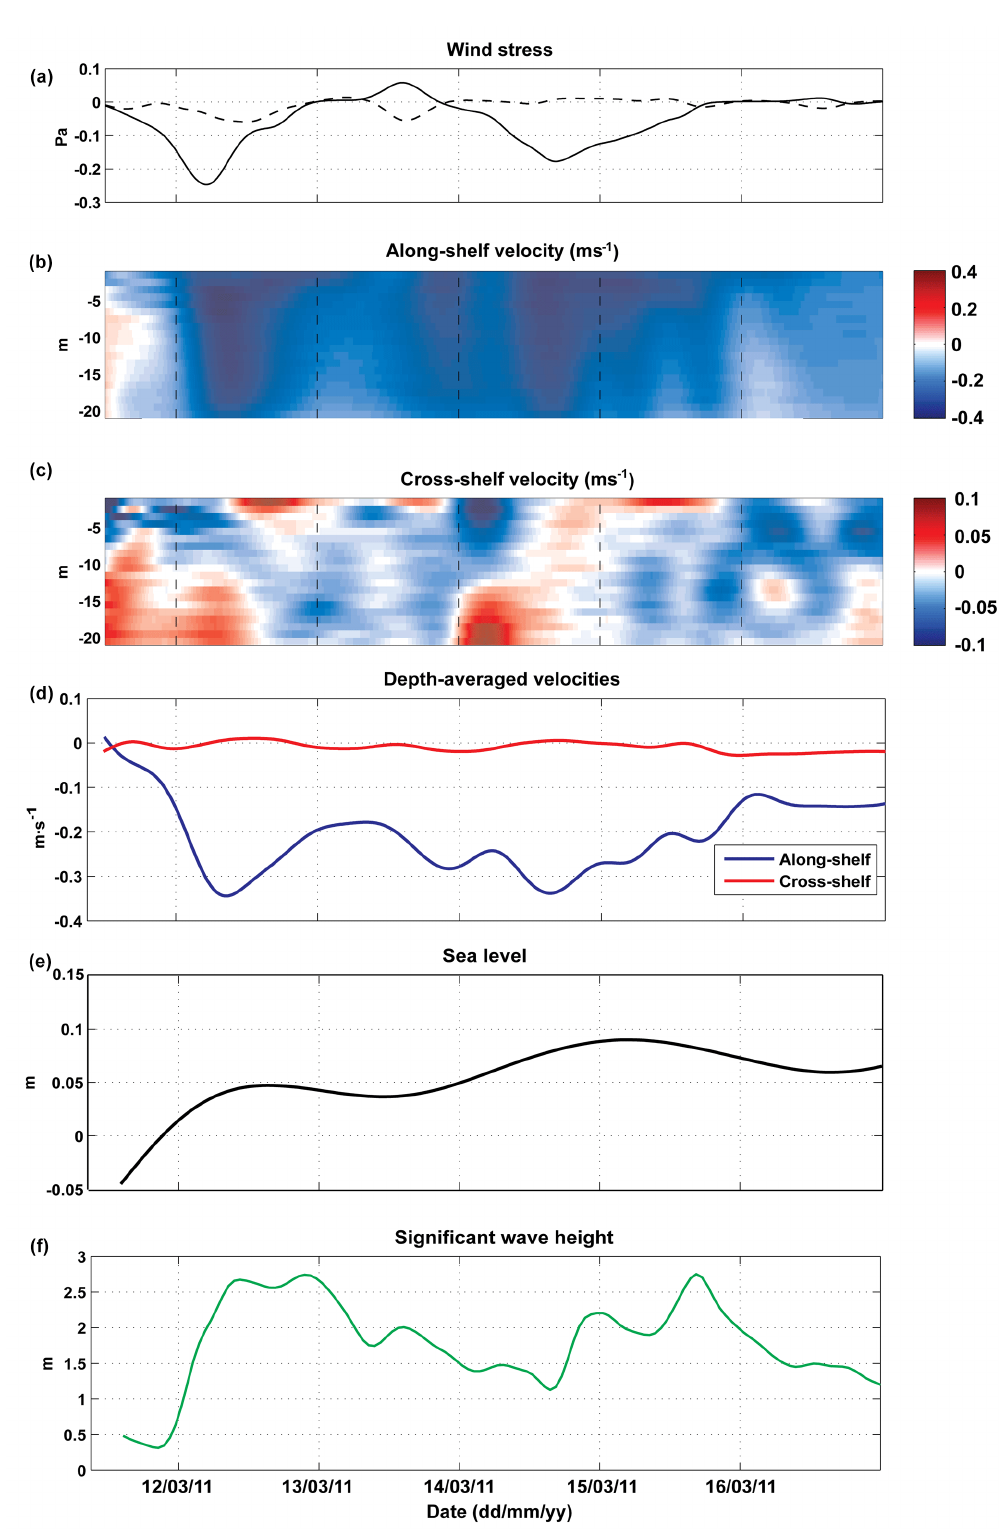
Figure 3. (a) Time series of wind stress measured at the CSO (the continuous line for the along-shelf wind component and the dashed line for the cross-shelf wind component). (b) Along-shelf velocity. (c) Cross-shelf velocity. (d) Depth-averaged along- and cross-shelf velocities. (e) Detided sea-level variations. (f) Significant wave-height. The velocities and sea-level fluctuations were measured at station A2, and the wave conditions at station A3. The date indicates